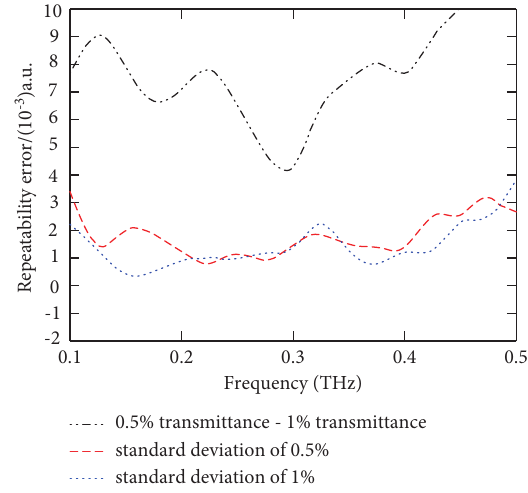
Figure 5: Repeatability error analysis.